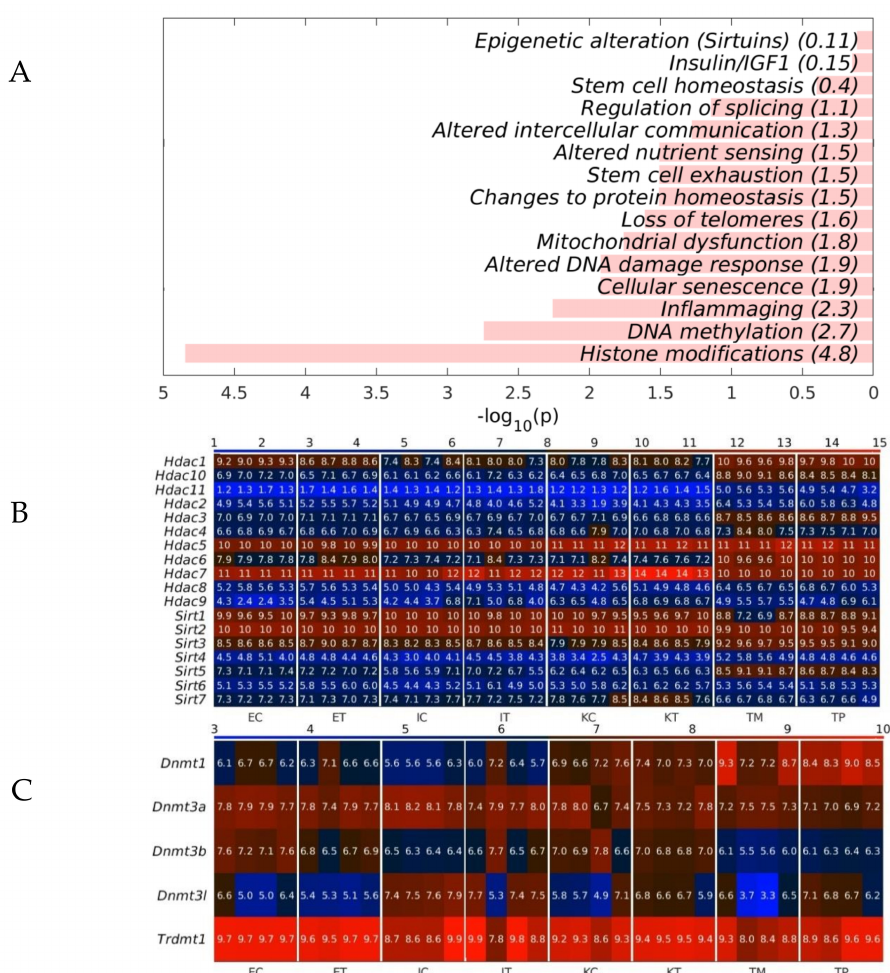
Figure 8. Statistical enrichment of the hallmarks of the geromiRs downregulated in the tumor microenvironment (TME). ( A ) Bar plots of the − log 10 ( p ) of the statistical enrichment of the hallmarks of the geromiRs downregulated in TME. ( B ) Heatmap of the expression of the histone deacetylases (HDACs) and of the Sirtuins. ( C ) Heatmap of the expression of the DNA methyltransferases. The color bars codify the gene expression in log 2 scale. Higher gene expression corresponds to redder color. The samples are denoted with E, I and K for endothelial, Ito and Kupffer cells, C and T for the control and the TME cells and TP and TM for the CRC primary and liver metastasis cells, respectively. 2.4. Cercam and Spsb4 Upregulated in the TME Cells Were Identified as an Element of